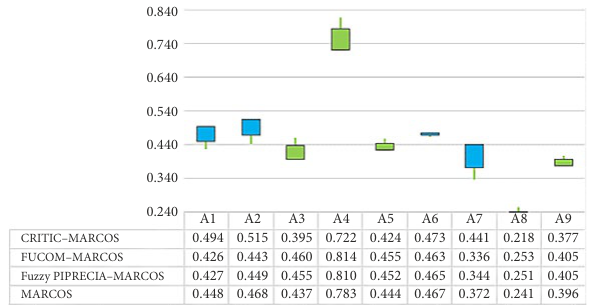
Figure 3. Results of SA using various criterion weight approaches